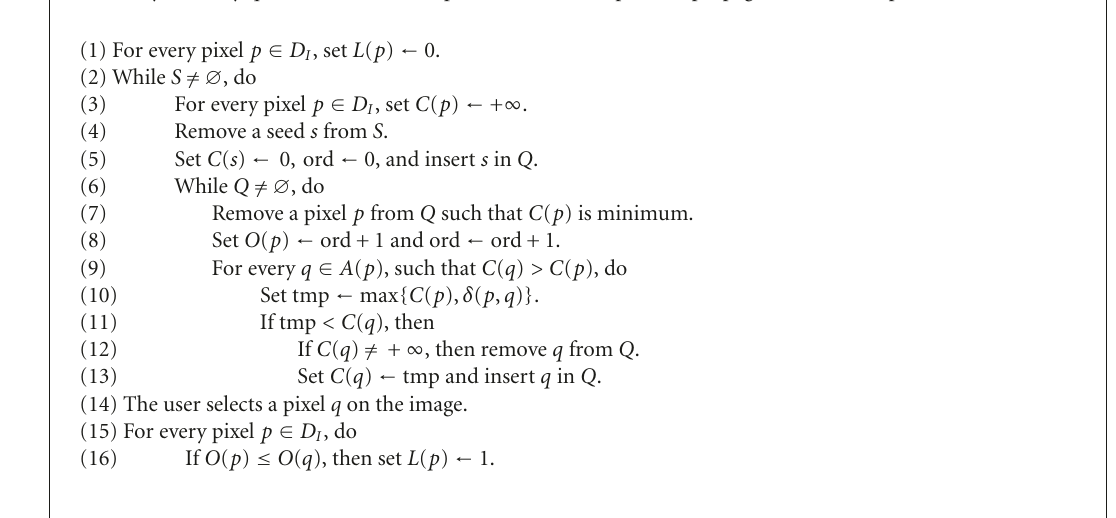
Algorithm 3: Single object definition without seed competition.